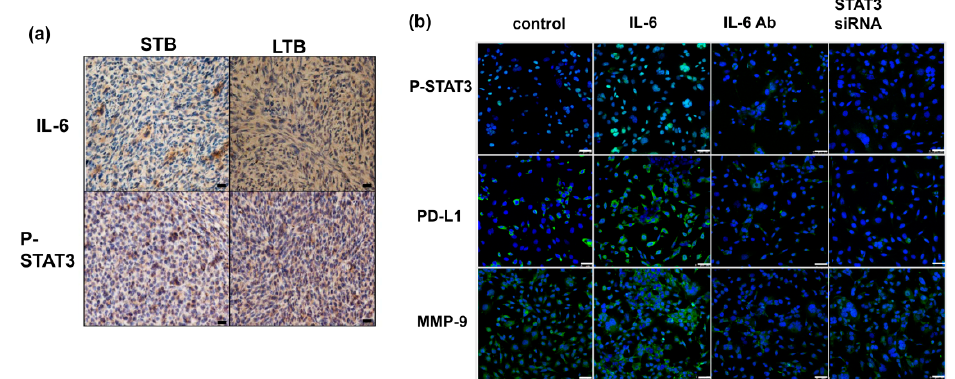
Figure A4. Role of IL-6 signaling in the expression of CD44. ( a ) The expression levels of IL-6 and CD44 were evaluated by IHC using ectopic LTB and STB tumors. Scale bars: 20 µm. ( b ) The levels of PD-L1 and MMP-9 were evaluated by IF for TRAMP-C1 cancer cells with regulating IL-6 signaling in vitro (IL-6, cells stimulated with IL-6; IL-6 Ab, cells treated with IL-6 neutralization antibody; STAT3 siRNA, cells transfected with STAT3 siRNA ) . Scale bars: 50 µm.